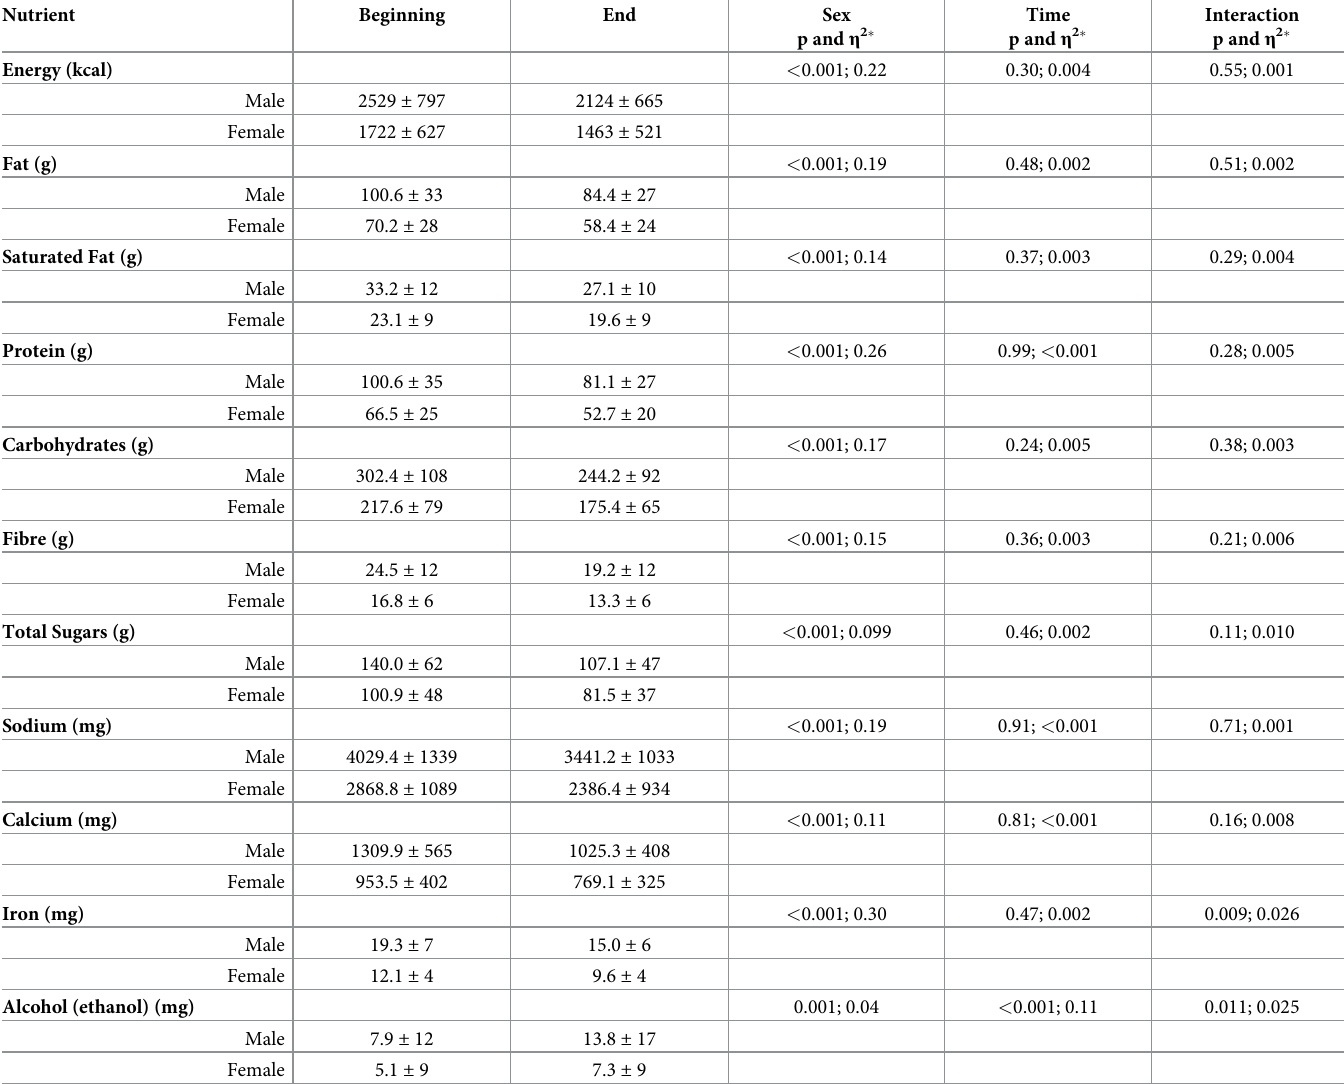
Table 2. Nutrient intake data expressed as a unit per day from beginning to end of first-year university in male (n = 50) and female (n = 210) students.